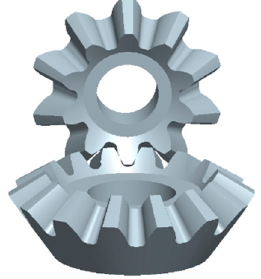
Figure 2. Illustration of assembling models.